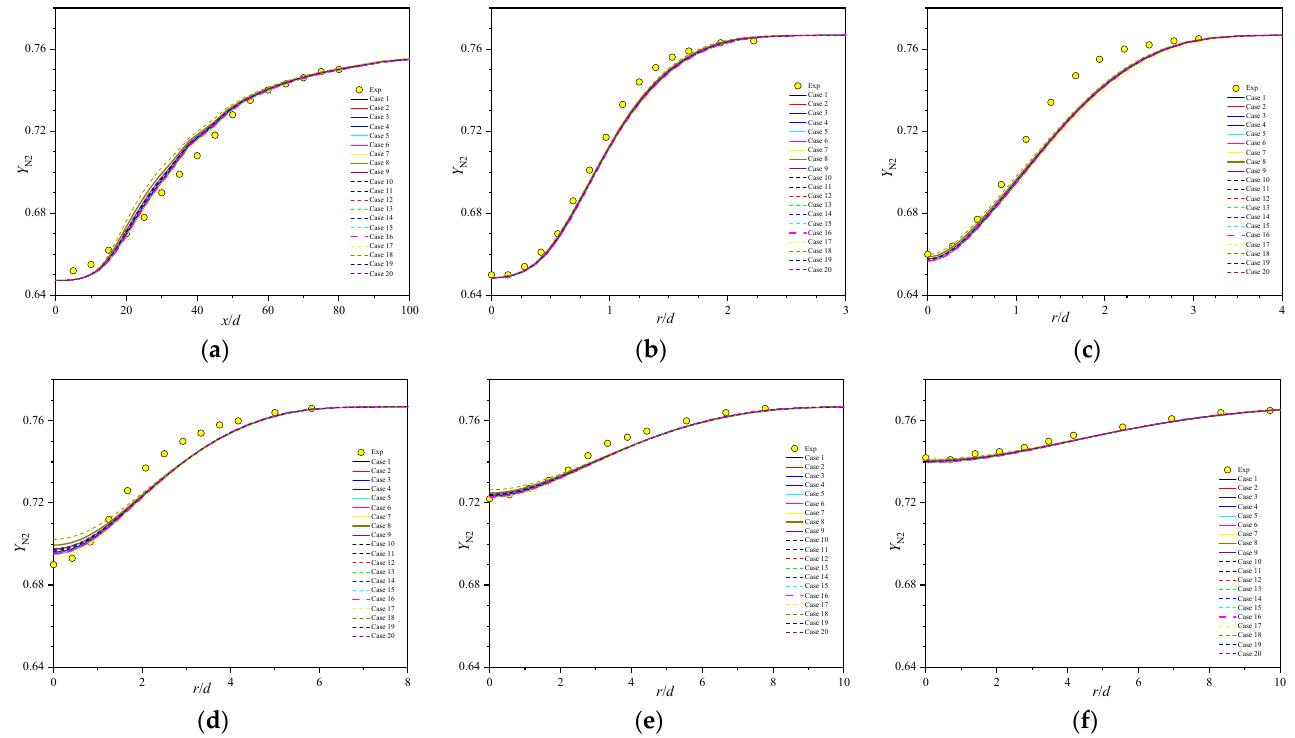
Figure 9. Comparison of measured [22,24] and predicted mean N 2 mass fraction profiles for the Sandia Flame D with 20 combinations of the primary EDC constants C D1 and C D2 . ( a ) @axis. ( b ) @ x / d = 7.5. ( c ) @ x / d = 15. ( d ) @ x / d = 30. ( e ) @ x / d = 45. ( f ) @ x / d = 60. Under-predicted mean O 2 mass fraction profiles along the axis and the radii are found in all cases, as shown in Figure 10, and occur at the zones where the mixtures burn intensely, which indicates that the mean reaction rates are largely over-predicted. Very small differences are found for the predicted mean O 2 mass fraction profiles among the 20 cases for the zones where the reactions of mixtures are near completion, such as at x / d = 45 and 60.